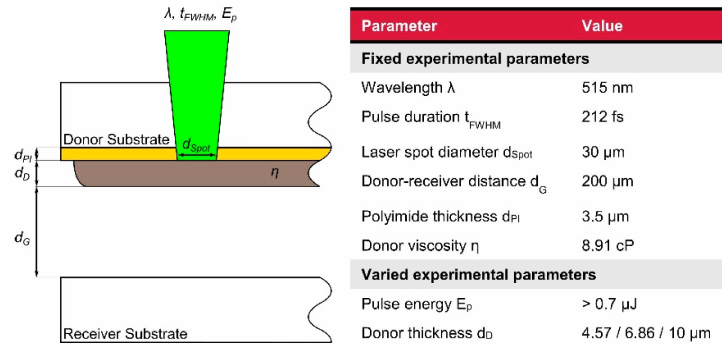
Figure 3. Important parameters of the BA LIFT